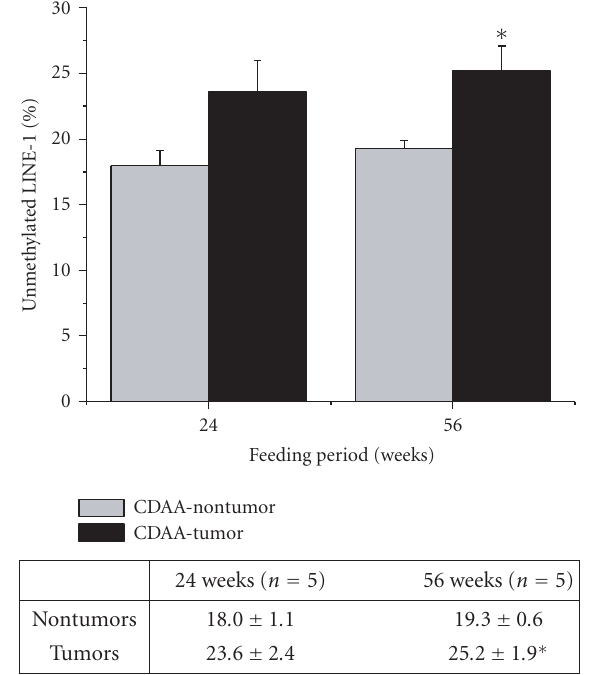
Figure 4: Percentage of unmethylated cytosine in total (methylated plus unmethylated) cytosine in LINE-1 sequences in tumor or non- tumor liver tissue in CD-diet fed rats. Actual data are shown in the table under the graph. Statistically significant di ff erences ( ∗ ) are seen between nontumor and tumor at 56